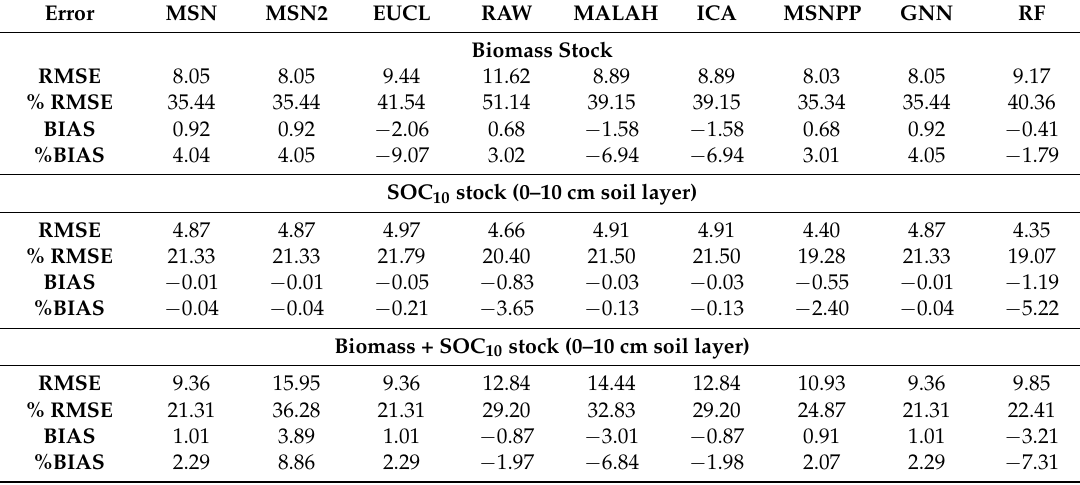
Figure 4. Bivariate relationships between the LiDAR metrics and biomass + SOC 10 (0–10 cm soil layer) C stock of Pinus halepensis plantations at Los Cuadros (Murcia, Spain). In all figures, the linear 1:1 line has been fitted. For these equations, the R 2 value is included (see Table 3 for RMSE values). Table 3. Root-mean-square error (RMSE) and bias of bivariate relationships between LiDAR metrics and biomass C stock (Mg C ha − 1 ) and Soil Organic Carbon stock (SOC depth –S, Mg C ha − 1 ) models of Pinus halepensis plantations at Los Cuadros (Murcia, Spain).